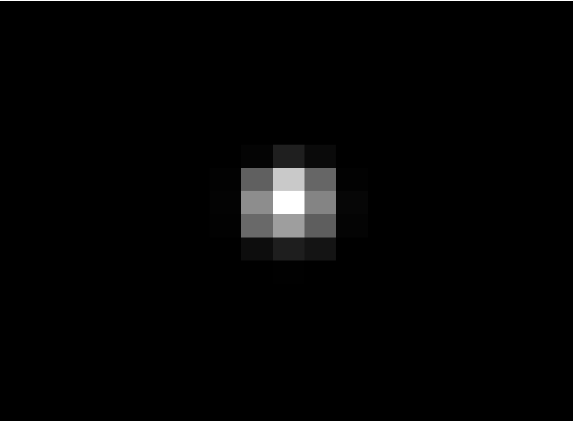
Figure 12. The simulation results of distorted star maps with the previous study [27].